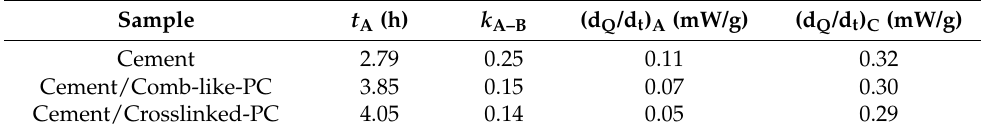
Table 3. The cement hydration parameters extracted from the heat evolution